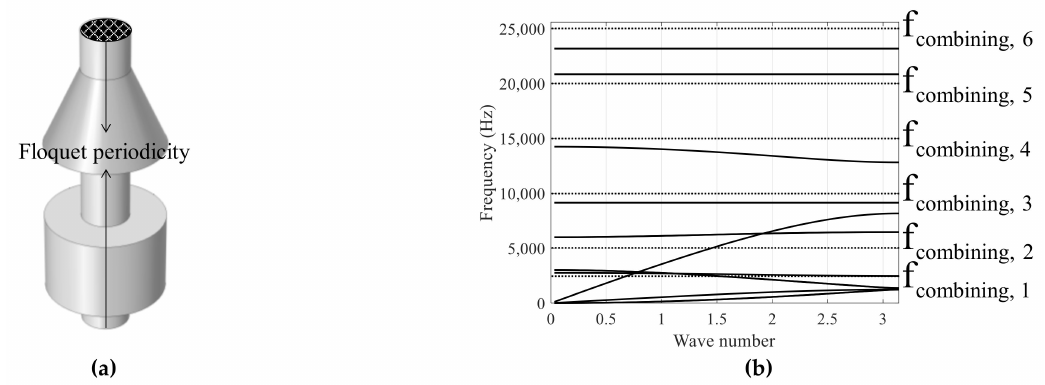
Figure 11. ( a ) Floquet periodic condition of unit cell and ( b ) dispersion relation for a unit cell in combining cylindrical and conical metamaterials ( r p = 0.03 m, h p = 0.02 m, s = 0.02 m, n = 5 )